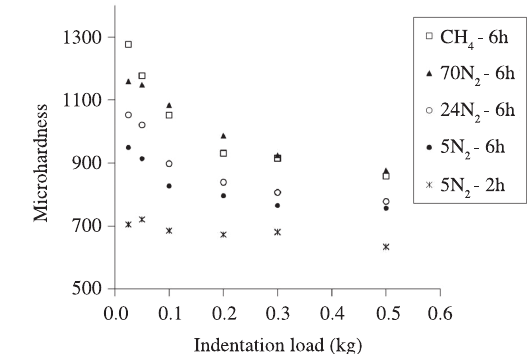
Figure 9. Surface hardness estimation of nitrided